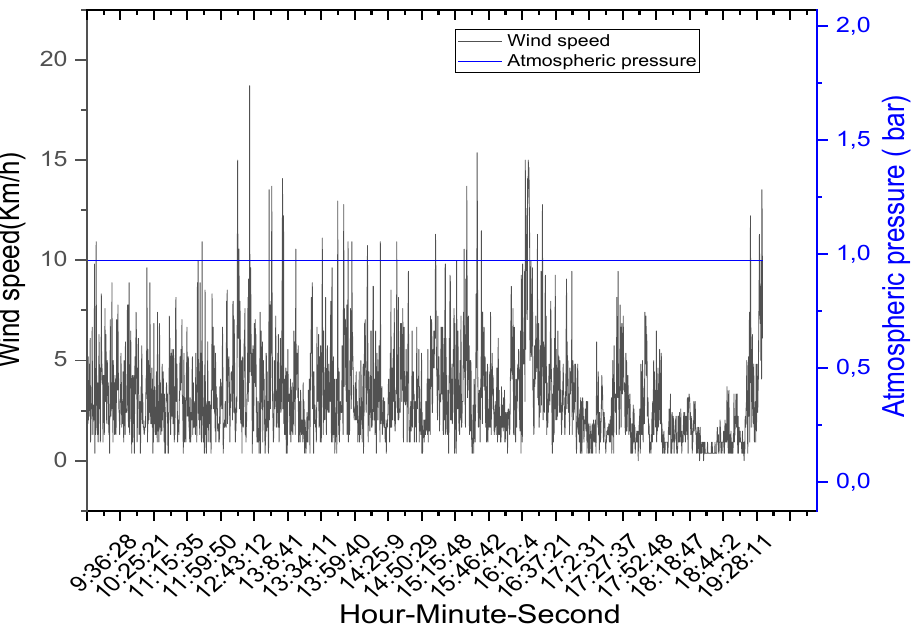
Figure 6c: Variation of wind speed and atmospheric